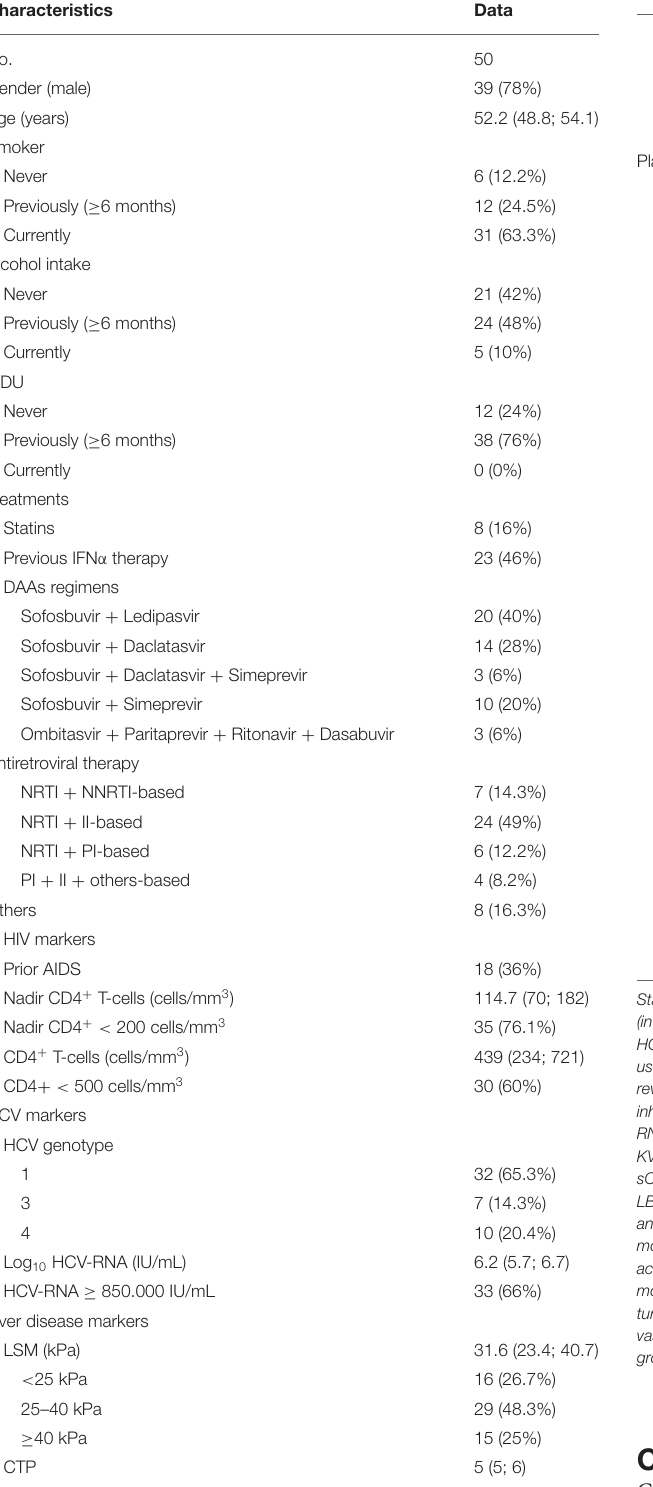
Clinical Data and Samples Clinical data and samples were collected at the baseline (initiation of HCV treatment) and at the end of follow-up (48 weeks after completing HCV